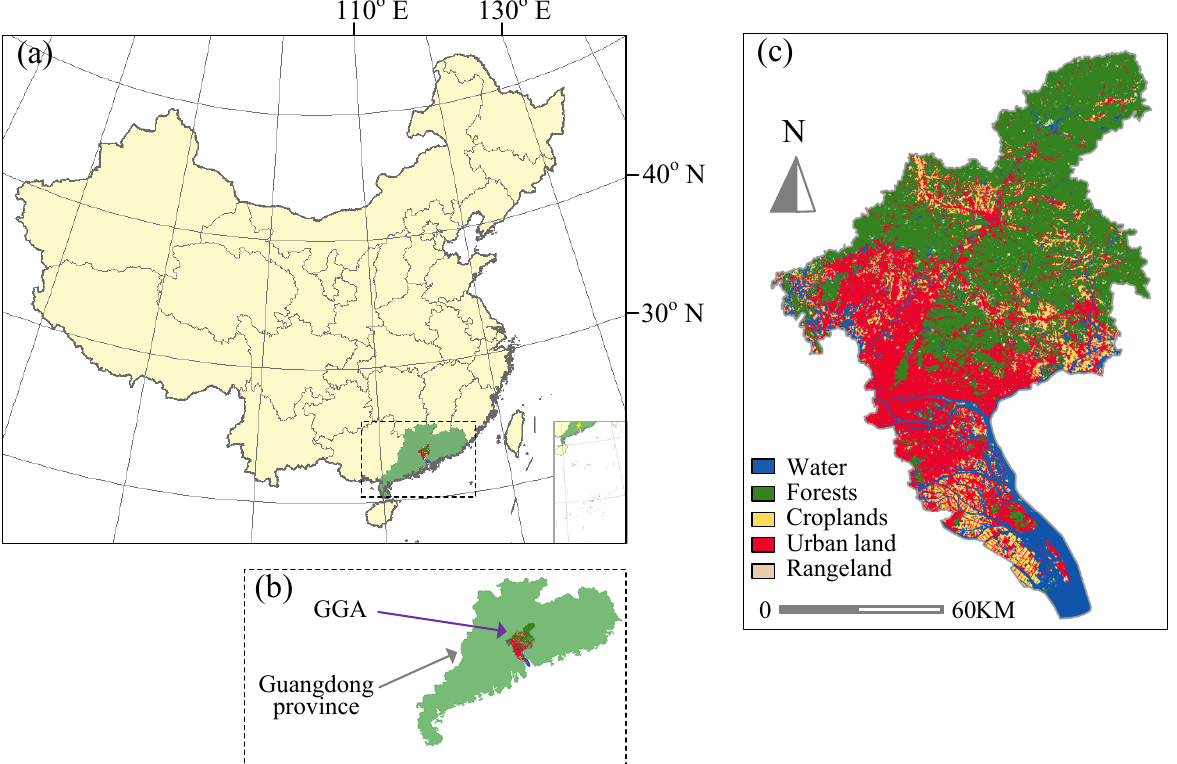
Figure 1. The study area: ( a ) The provincial boundaries of China. ( b ) The administrative boundary of Guangdong province, where the study area (the greater Guangzhou area, GGA) is located. ( c ) The land (vegetation) cover classes in GGA.